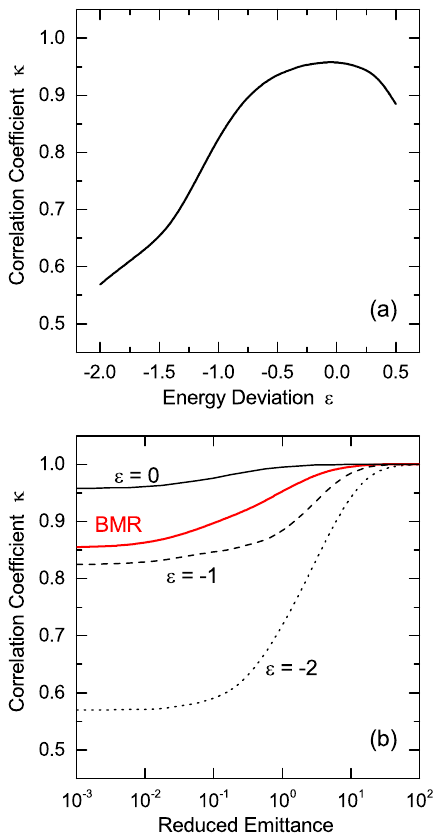
FIG. 6. Correlation coefficient κ of the Wigner function in the case of UR, which is plotted as a function of (a) the energy deviation and (b) emittance of the electron beam for three different values of energy deviation. The red line in (b) shows that for BMR computed at the critical